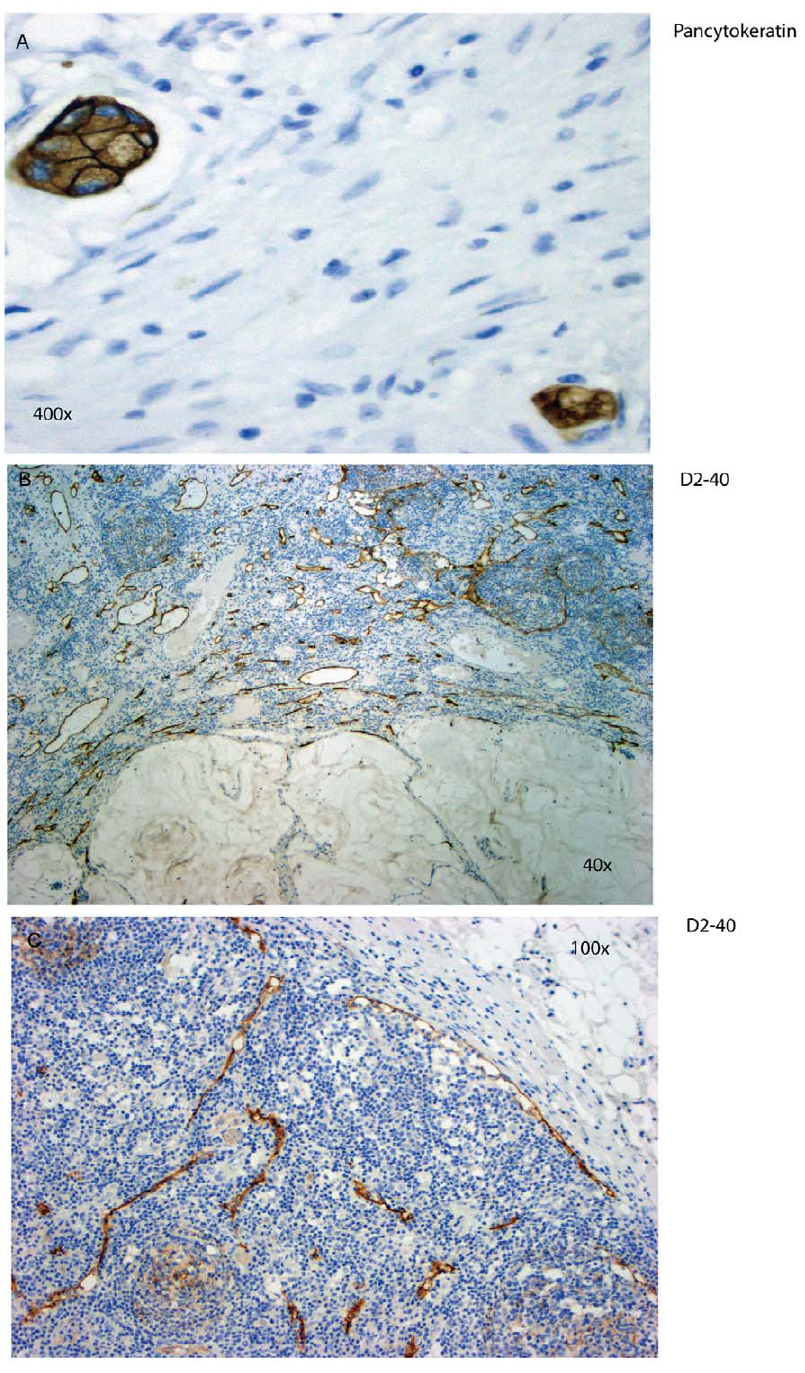
Figure 1. Immunohistochemistry of regional lymph nodes. A. Immunohistochemistry for Pancytokeratin to detect lymph node micrometastases. B. Podoplanin staining with D2-40 in a lymph node with metastasis. The red to brown staining marks lymph vessels. C. Podoplanin staining with D2-40 in a lymph node without metastasis.